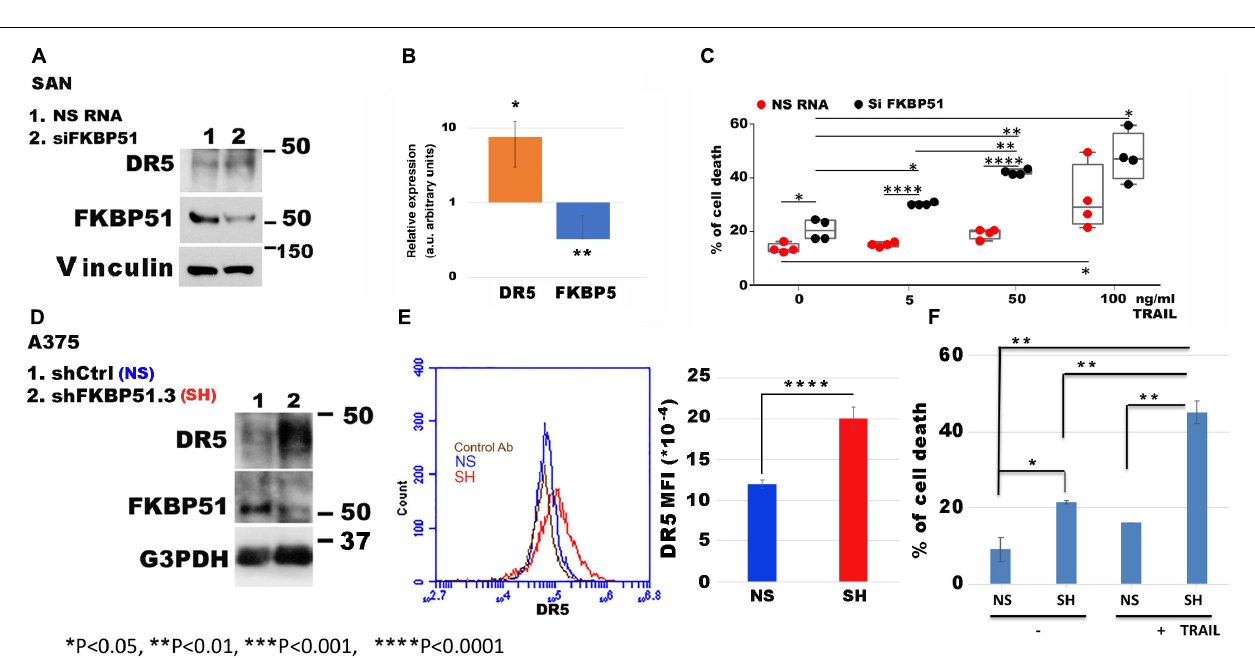
FIGURE 2 | FKBP51 targeting affects DR5 expression and TNF-related apoptosis-inducing ligand (TRAIL) sensitivity to apoptosis. (A) Western blot assay of DR5 and FKBP51 expression in SAN melanoma cell line silenced or not for FKBP51. Vinculin was used as a loading control. The blot is representative of three experiments. (B) Analysis by RT-qPCR of DR5 and FKBP5 gene expression in SAN cell line in the condition of FKBP51 silencing ( N = 5). Expression was relative to NSRNA-treated cell expression that was used as the reference sample (expression = 1). (C) Graphic representation of flow cytometric values of cell death in SAN melanoma cell cultures with TRAIL (each bullet represents the mean of triplicates). (D) Analysis by Western blot assay of DR5 and FKBP51 expression in A375 melanoma cells stably transfected with a non-silencing (NS) or FKBP51-silencing (SH) short hairpin RNA. G3PDH was used as a loading control. (E) Left, flow cytometric histograms in overlay of DR5 expression, measured in NS or SH A375 cells. Right, mean ± SD ( N = 4) of DR5 mean fluorescence intensities. (F) Mean ± SD ( N = 3) of cell death values in NS or SH A375 cell cultures with 100 ng/ml TRAIL.